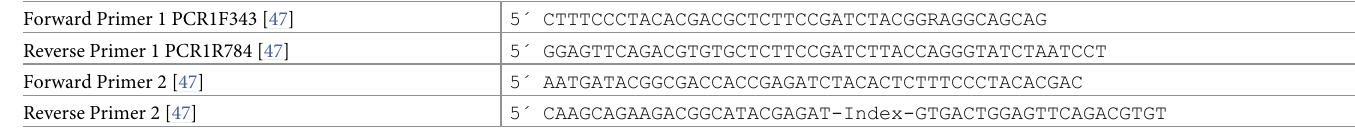
Table 1. Sequences of the primers used for the DNA